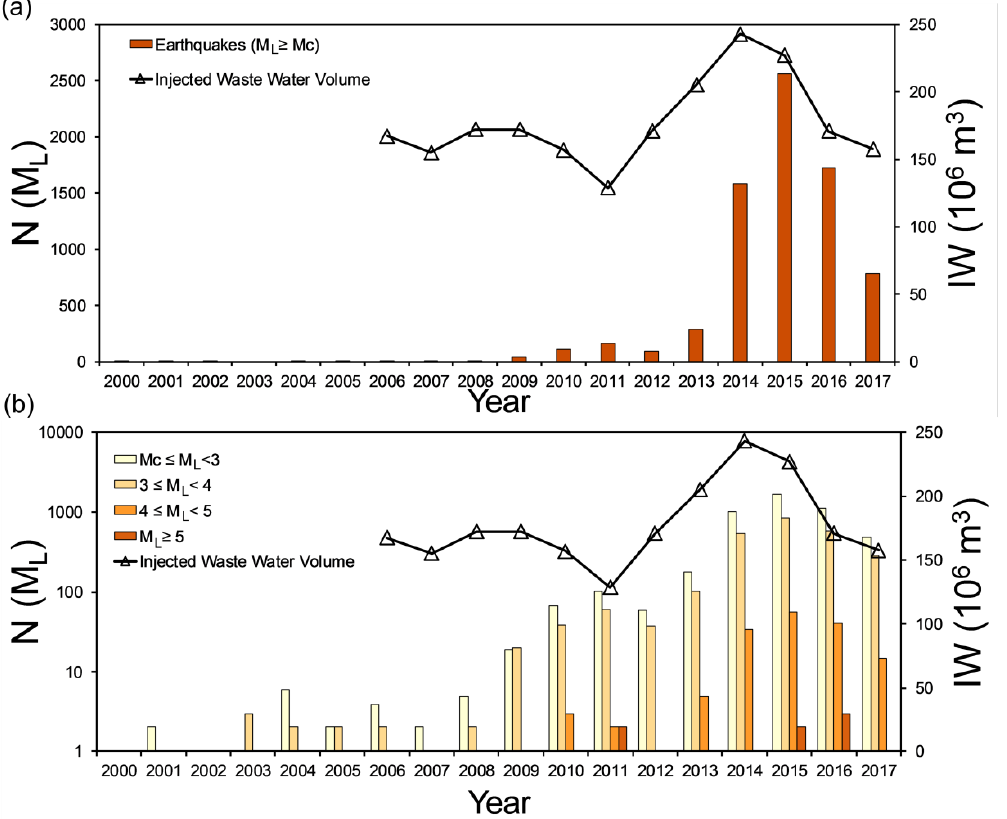
Figure 3. ( a ) Time series of total annual number of earthquakes (N(M L )) with M L ≥ M C (red bars) and oil/gas industry-related injected volumes of wastewater (IW) in million cubic meters (white triangles) in Oklahoma from 2000 to 2017. ( b ) Time series of total annual number of earthquakes (N(M L )) with M L ≥ M C per magnitude range between 2000 and 2017 and oil/gas industry-related volumes of wastewater injected (IW) between 2006 and 2017 in Oklahoma. Note the log scale for N(M L ) in ( b ). 100 years [29]. Between 2010 and 2012 Oklahoma was ranked as the 5th highest producing